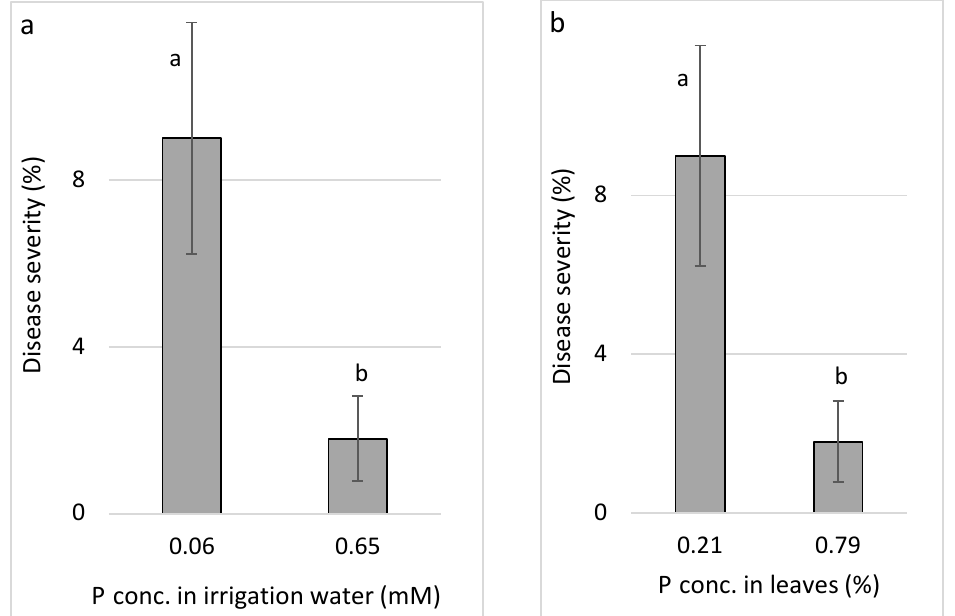
Figure 2. Effect of P concentration treatments in the irrigation water on cucumber downy mildew (CDM, Pseudoperonospora cubensis ). CDM severity is presented in relation to P concentration in the irrigation water ( a ) and in relation to the P concentration in the leaves ( b ). The disease was evaluated on a 0 to 100% severity scale, where 0% = healthy leaves and 100% = leaves completely covered by CDM symptoms. In each graph, values for each P treatment followed by a common letter are significantly not different from each other according to Tukey-Kramer’s HSD test ( p ≤ 0.05). K (Expts B-K-f): Increasing the concentration of K in the fertigation solution from 0.5 to 5.1 mM resulted in a gradual increase in K concentration in the cucumber leaves up to 4.79% of the leaf dry weight (Figure 3a). An increase in the K concentration in the irrigation water resulted in a gradual increase in CDM severity (Figure 3b). Similarly, the change in K leaf concentration resulted in a gradual increase in disease severity (Figure 3c). Calculation of the relationship between K concentration of individual plants and CDM severity resulted in a positive correlation (Results not presented).